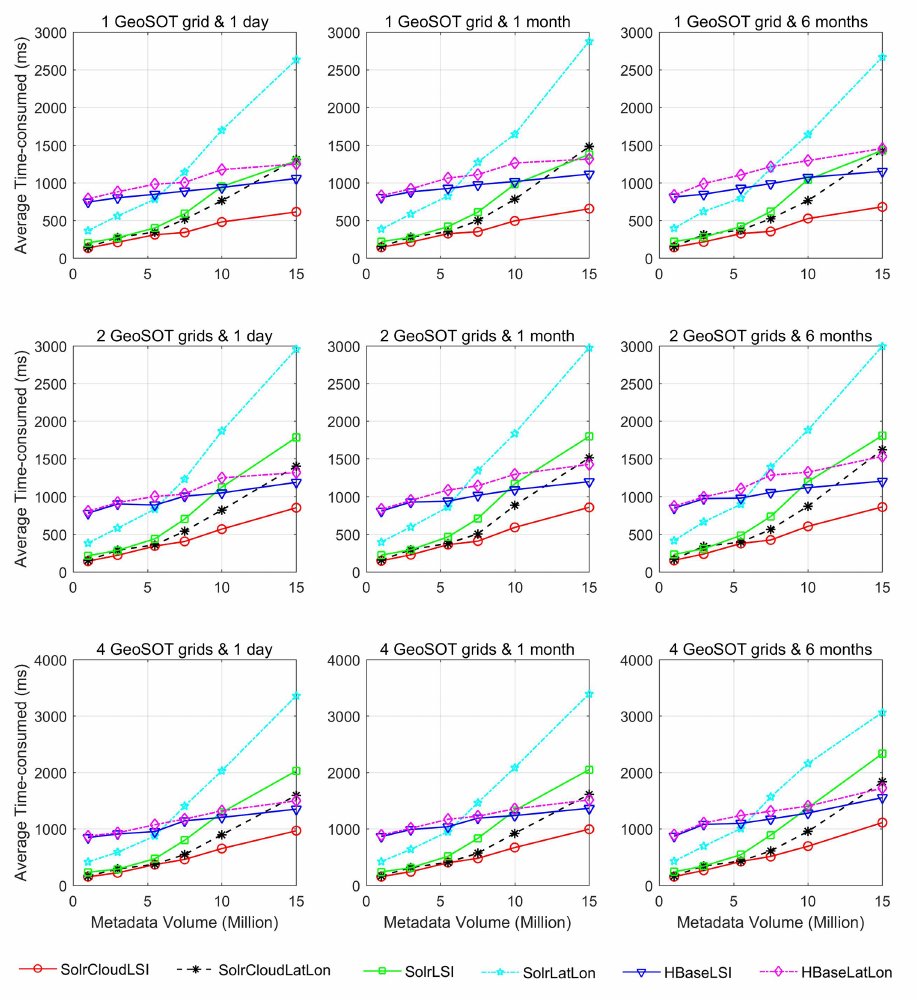
Figure 9. The results of all comparative